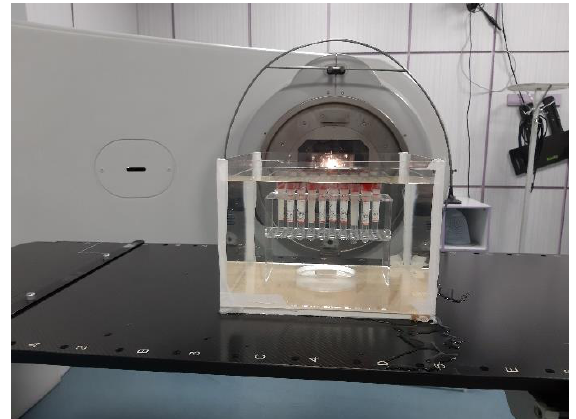
Fig. 3. Irradiation set-up using compact external beam radiotherapy Figure 3 : Irradiation set-up using compact external beam radiotherapy machine